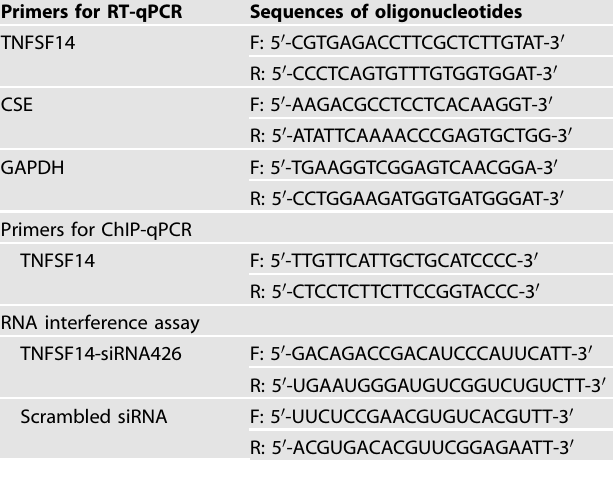
Table 2. Correlation between TNFSF14 expression with clinicopathological characteristics of